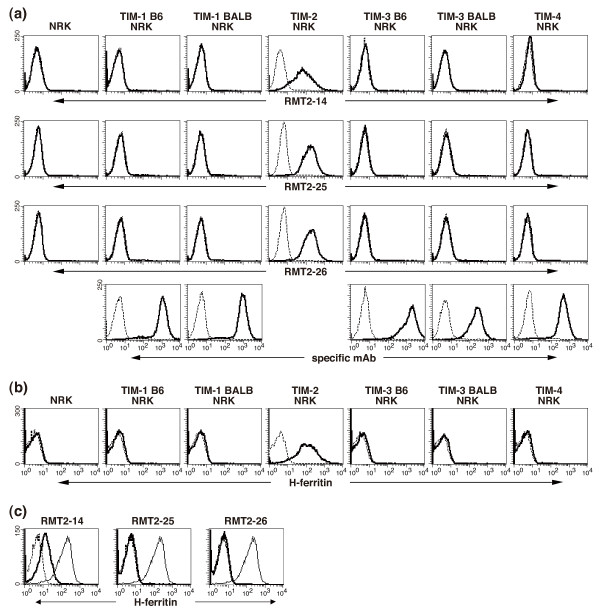
Characterization of anti-TIM-2 mAbs. (a) Reactivity of anti-T cell immunoglobulin and mucin domain (TIM)-2 monoclonal antibodies (mAbs) to mouse TIM family molecules. NRK-52E-derived TIM transfectants and parental cells were stained with biotinylated RMT2-14, RMT2-25, RMT2-26, specific mAbs against each TIM family molecule, or control IgG followed by PE-labeled streptavidin. Thick lines indicate the staining with the respective mAb and the dotted lines indicate background staining with control IgG. (b) H-ferritin binds to TIM-2 transfectant. NRK-52E-derived TIM transfectants were stained with Alexa647-labeled H-ferritin. Thick lines indicate the staining with the H-ferritin and the dotted lines indicate background staining with PBS. (c) Anti-TIM-2 mAbs inhibit H-ferritin binding to TIM-2 transfectant. TIM-2/L5178Y cells were pretreated with the indicated anti-TIM-2 mAb (thick lines) or control IgG (solid lines) and then stained with Alexa647-labeled H-ferritin. The dotted lines indicate background staining with PBS.